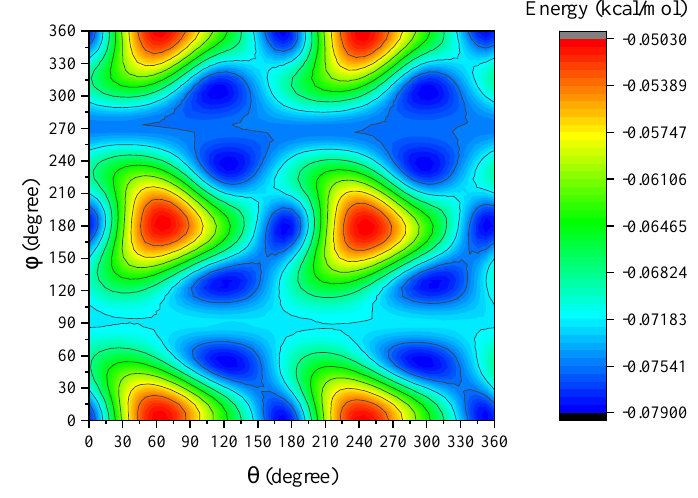
Figure 4. Contour plot of energy against θ and φ for the interaction between two dye